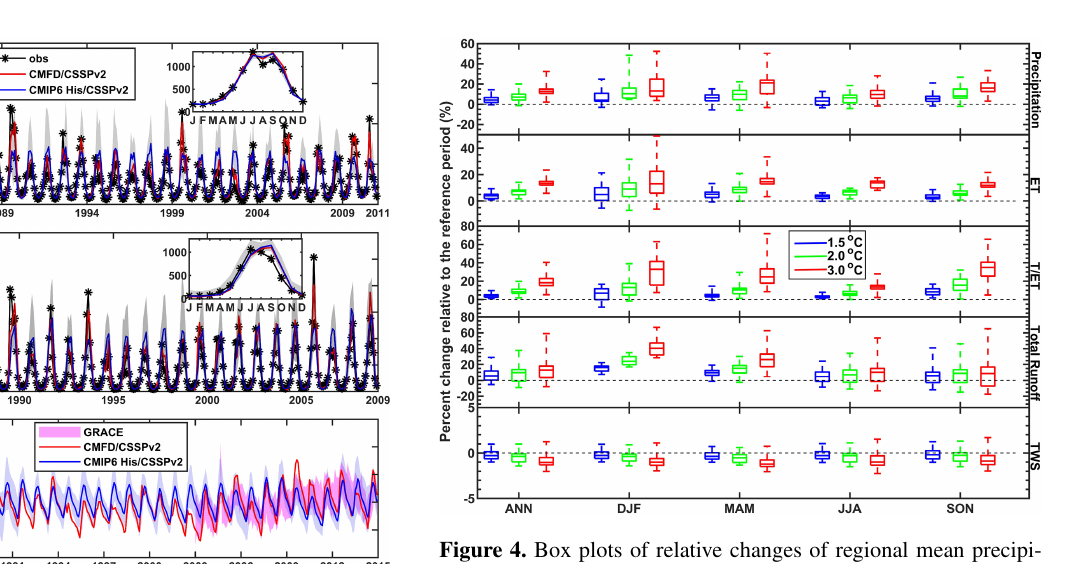
Figure 4. Box plots of relative changes of regional mean precipi- tation, evapotranspiration (ET), ratio of transpiration to evapotran- spiration ( T / ET), total runoff and terrestrial water storage (TWS) at different global warming levels. The reference period is 1985– 2014, and annual (ANN) and seasonal (winter: DF, spring: MAM, summer: JJA and autumn: SON) results are all shown. Boxes show 25th to 75th ranges among 22 CMIP6_SSP/CSSPv2 simulations, while lines in the boxes are median values.